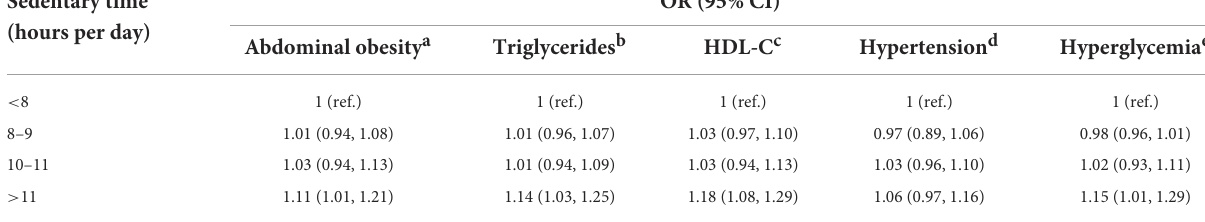
TABLE 4 Association between sedentary time and components of metabolic syndrome in 971 Tibetans in Garze Tibetan Autonomous Prefecture, Sichuan province, China. Sedentary